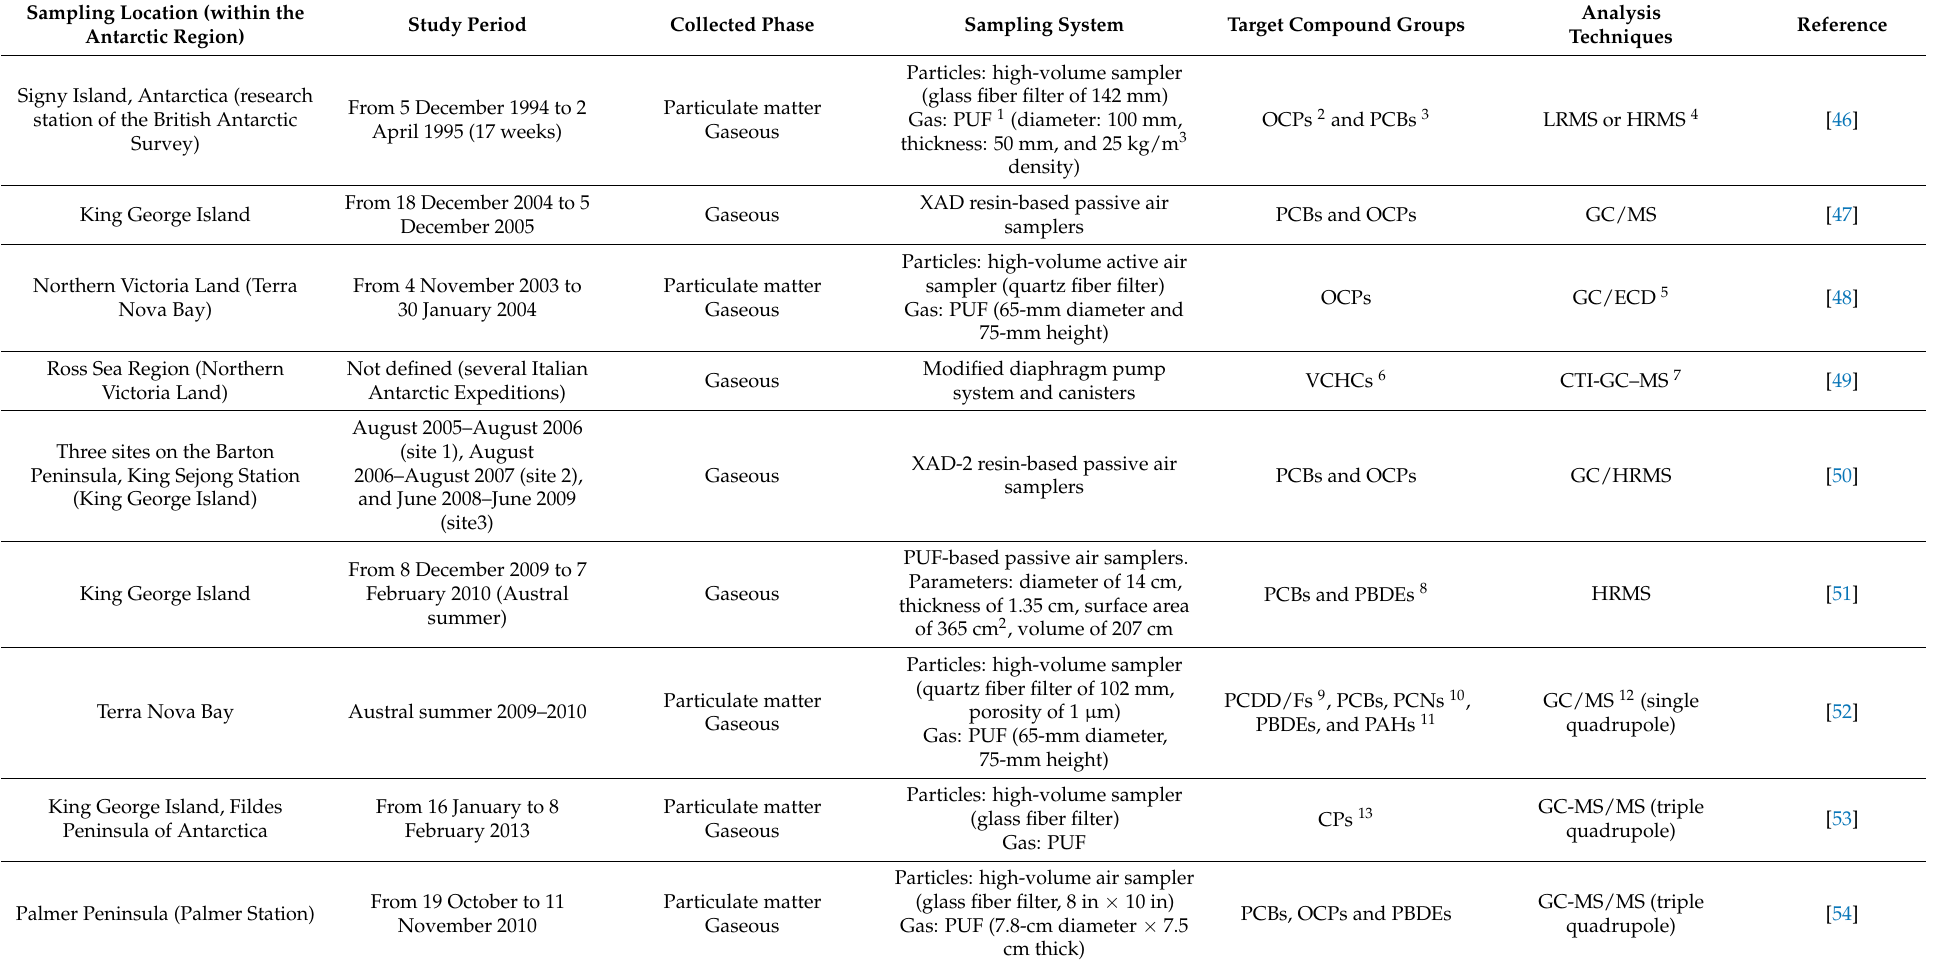
Table 1. Compilation of investigation studies on organic compounds carried out in the Antarctic